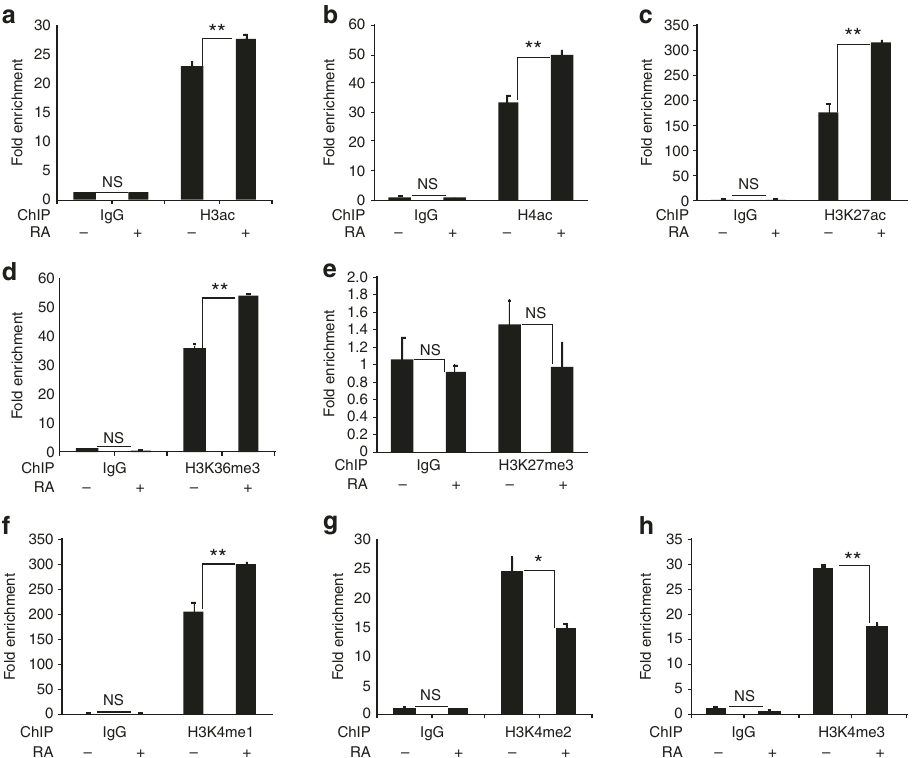
Fig. 6 Effect of RA treatment on different histone acetylation and methylation marks. a – h ChIP analysis of the Rar β promoter from NIH3T3 cells treated with 1 µ M RA during 1 h. ChIP was performed with speci fi c antibodies to H3ac a , H4ac b , H3K27ac c , H3K36me3 d , H3K27me3 e , H3K4me1 f , H3K4me2 g , and H3K4me3 h ( n = 3). In all graphs data represent mean ± s.e.m. NS — not signi fi cant, * P < 0.05 and ** P < 0.01. Student ’ s unpaired two-tailed t